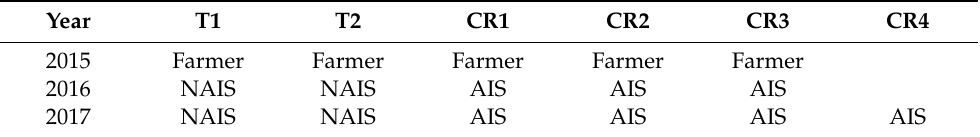
Table 2. Irrigation scheduling carried out in the di ff erent